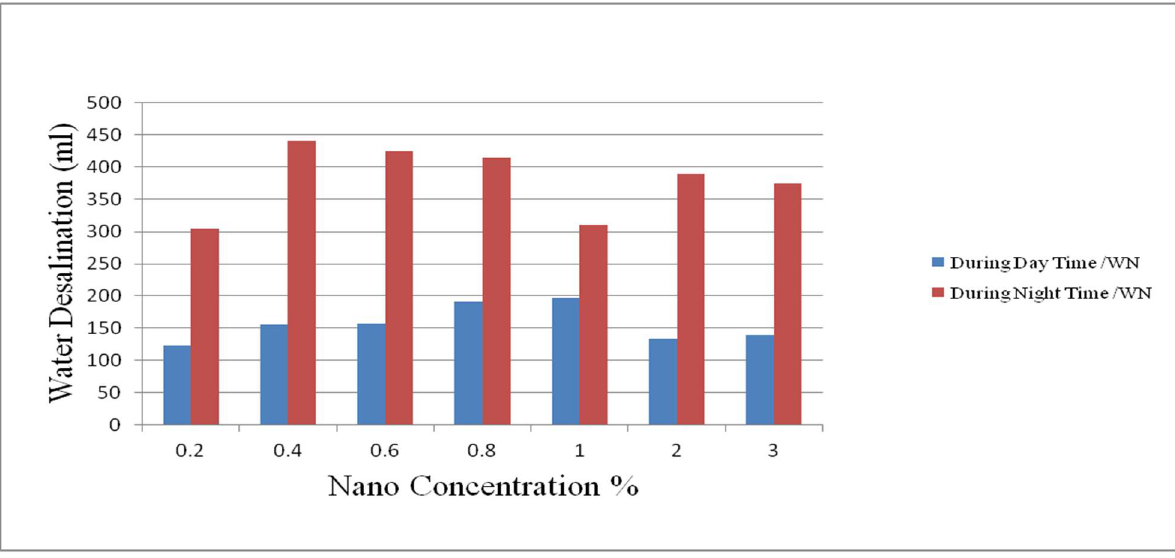
Figure 4. Effect of adding Al 2 O 3 daily on the amount of condensate.